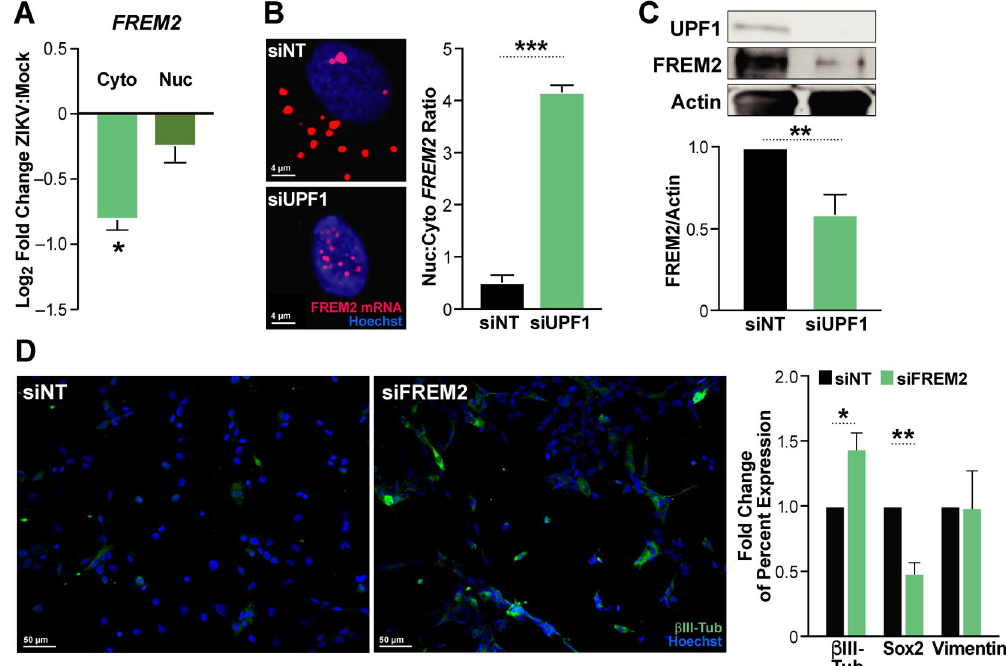
Fig 4. UPF1 knockdown leads to retention of FREM2 mRNA and decreased protein production, which alters differentiation markers. A) RT-qPCR of FREM2 in cytoplasmic and nuclear fractions in ZIKV-infected NPCs. B) RNAscope of FREM2 in UPF1 knockdown NPCs. NPCs were treated with siRNAs for 96 hours prior to harvesting for microscopy. Number of nuclear puncta compared to cytoplasmic as calculated by Imaris. 3 biological replicates, 10 cells per biological replicate per condition averaged. Statistics produced by Student’s t-test. C) Western blot of siNT and siUPF1 treated NPCs. NPCs were treated with siRNAs for 96 hours prior to harvesting for microscopy. Densitometric analyses of FREM2 were performed using ImageJ to quantify relative band intensities. D) siNT and siFREM2 treated NPCs stained for β III-Tubulin, Sox2 and Vimentin. NPCs were treated with siRNAs for 7 days prior to analysis. Statistics produced by Student’s t-test. � , P � 0.05; �� , P � 0.01; ��� , P � 0.001. Error bars are SEM. See S8 Fig for multi-channel images and S9 Fig for the western blots